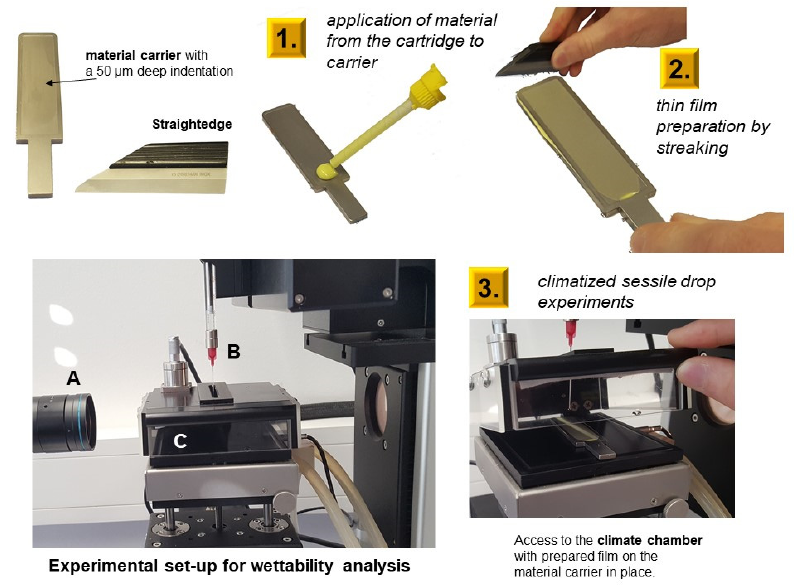
Figure 6. Specimen preparation and testing of hydrophilicity under 80% relative humidity. The wet- tability analysis set up contained a high speed video camera ( A ), microdrop dosage system ( B ), and climate chamber for specimen presentation ( C ).